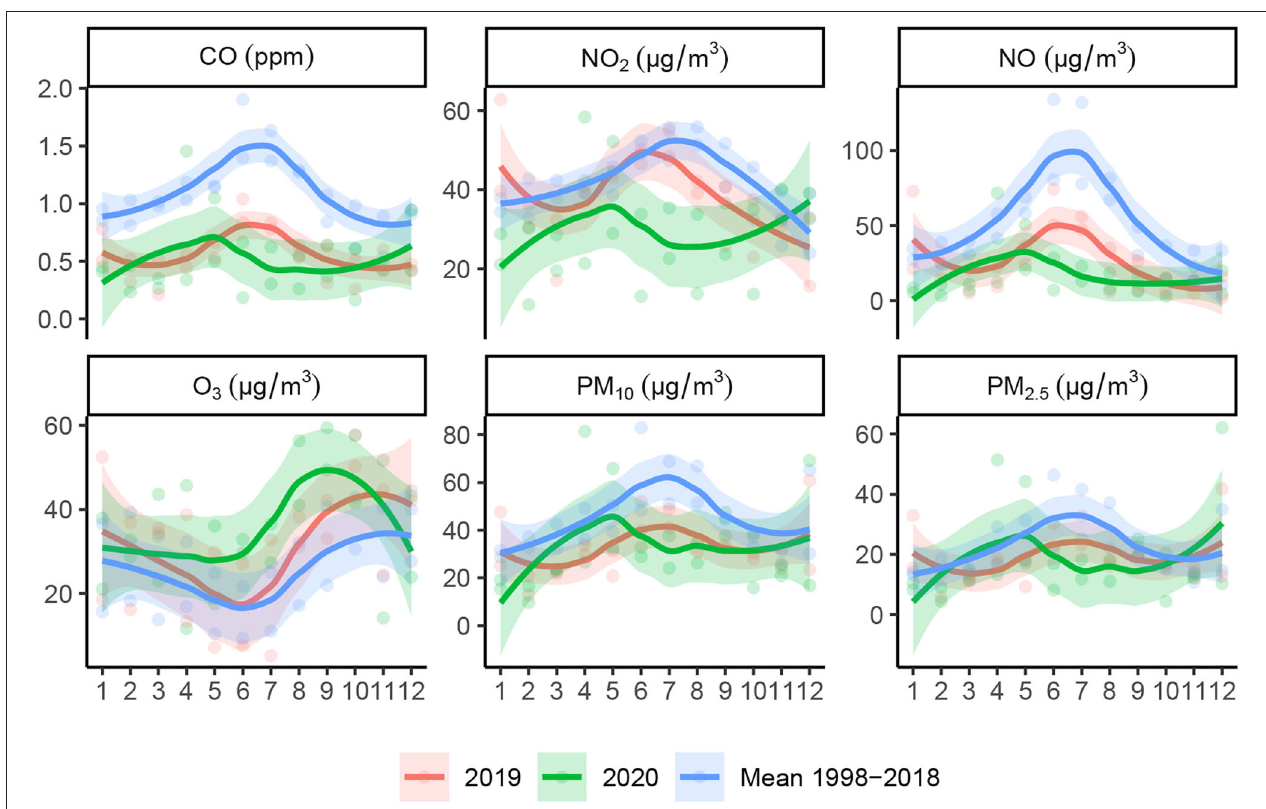
FIGURE 2 | Monthly average air pollutant concentrations in São Paulo for the periods 2020, 2019, and mean 1998–2018. The smooth line represents a LOESS regression (refer to